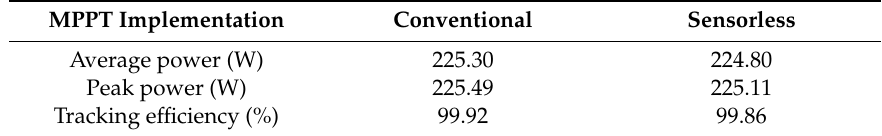
Table 4. Performance of the MPPT algorithms at the MPP under constant irradiation (1000 W / m 2 ).